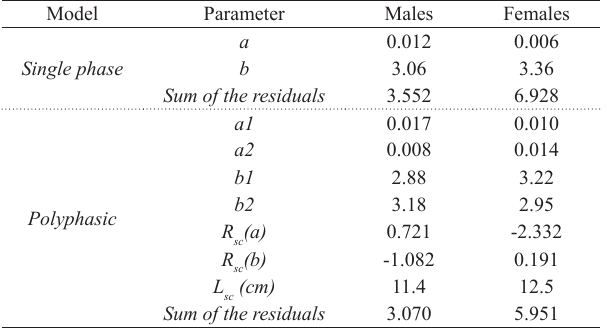
Table 1. Parameters obtained for the length/weight relationship for Auchenipterichthys longimanus by the adjustments to the single-phase and polyphasic models.